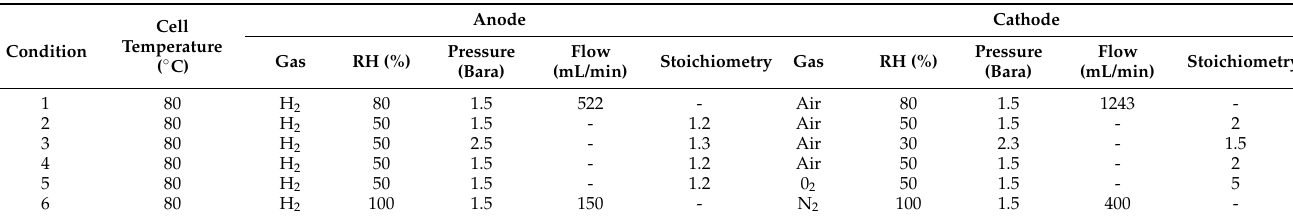
Table 3. Fuel cell test